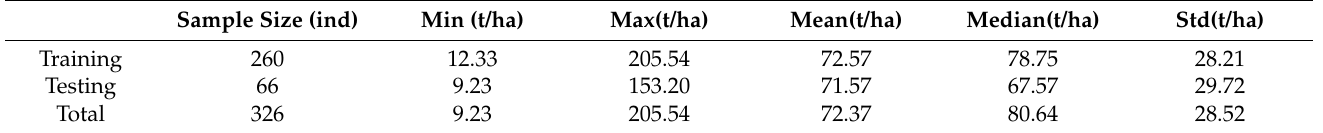
Table 2. The statistics of AGB in training, testing, and total sample datasets.